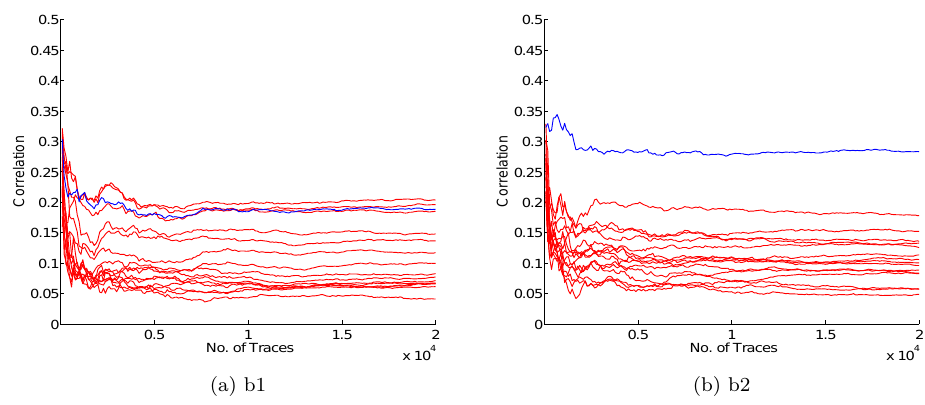
Figure 9: Enhanced CPA on encoded traces, blue line indicating correct key hypothesis and red lines indicating the wrong key hypotheses